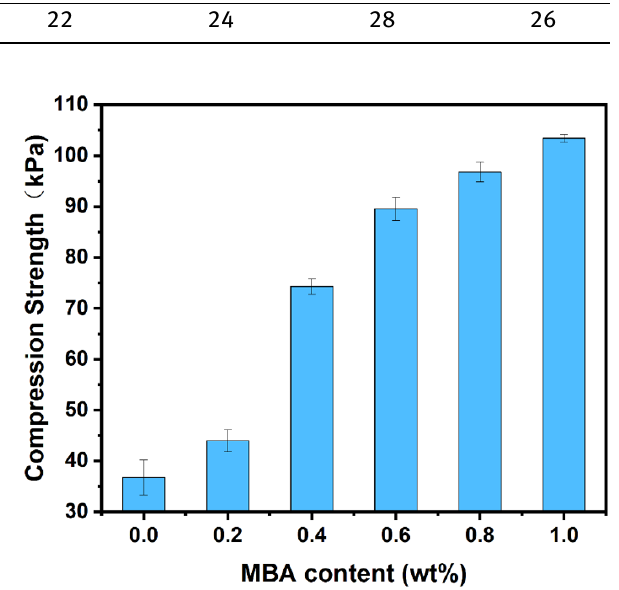
Figure 5: The re-swelled 3D printed cellulose hydrogel samples treated by cross linking agent solutions with different concentrations Table 1: The re-swelling property of the 3D printed cellulose hydrogel scaffolds treated by MBA/DMSO solution. MBA content (wt%)